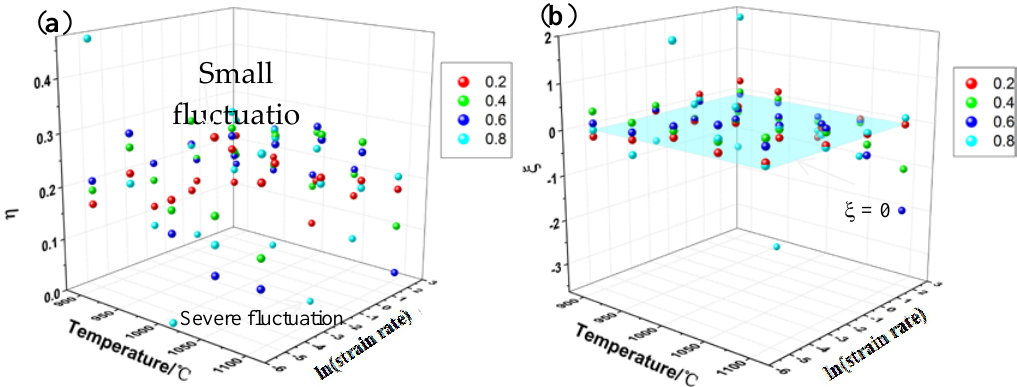
Figure 10. Three-D atomic distribution maps of value of ( a ) power dissipation efficiency and ( b ) instability parameter under different conditions.